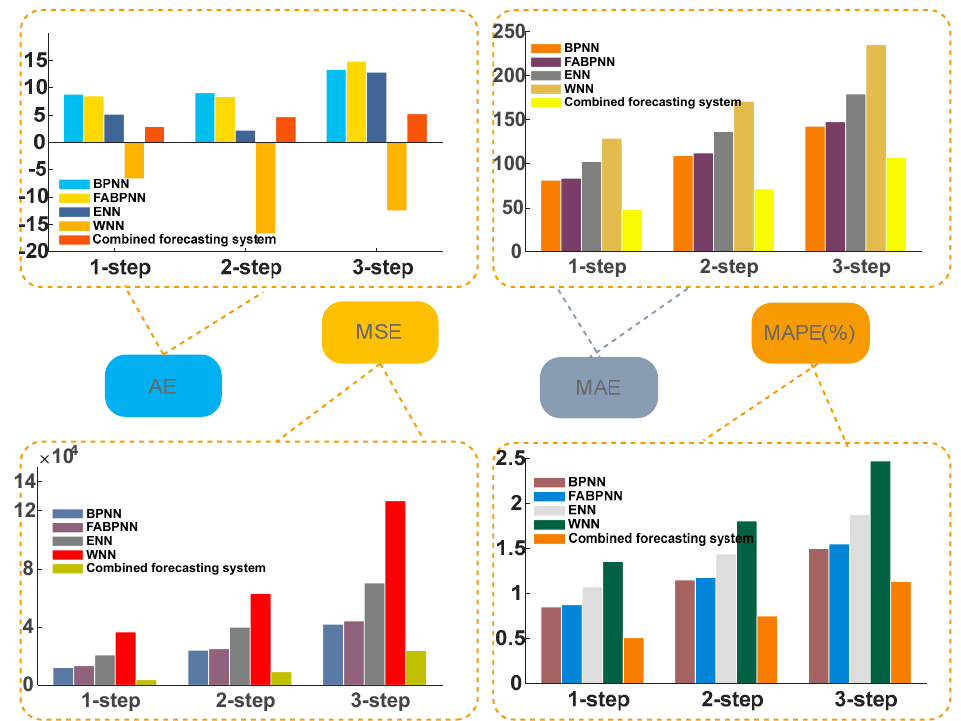
Figure 6. The results of AE, MAE, MSE and MAPE for June.